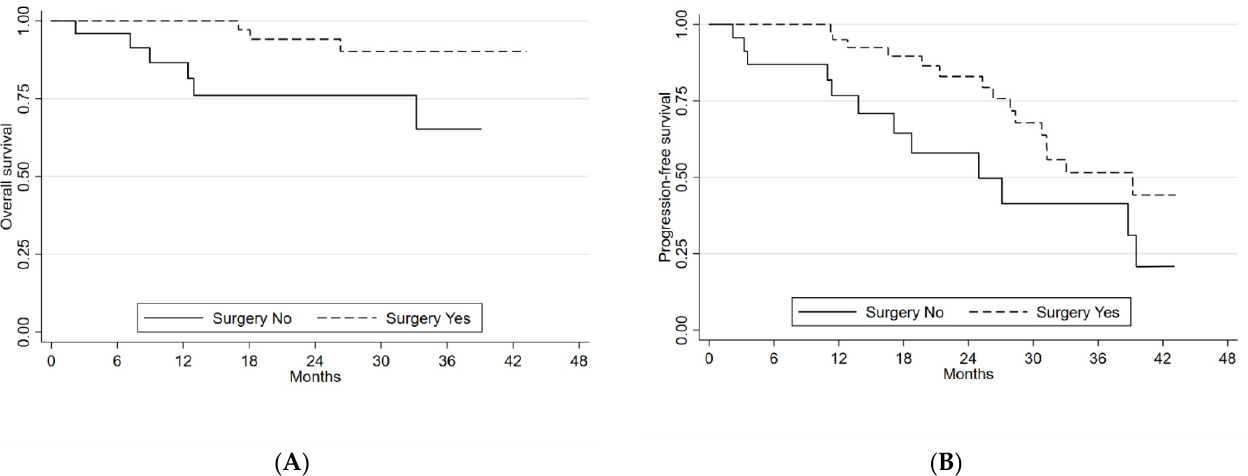
Figure 2. ( A ) Overall survival and ( B ) progression-free survival according to surgery. Median time to syndrome response was 5.0 months (95%CI 4.0–6.5). Time to best tumor response was 7.3 months (95%CI: 5.8–7.9) (Table S4 and Figure S3). In 20 of 65 (30.8%) patients included the 5-hydroxyindoleacetic acid (5-HIAA value was recorded at the pre-treatment visit and after the second cycle of treatment. The median basal value was 356.4 mg/24 h (normal range 2.0–10.0). The post second cycle median value was 28.5 mg/24